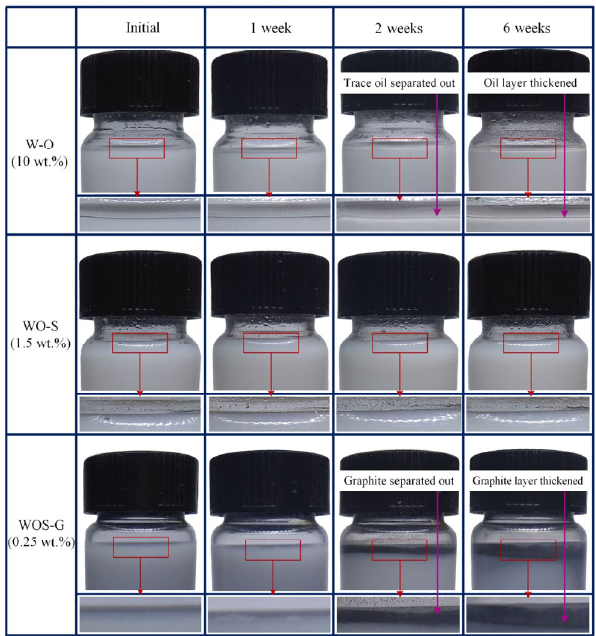
Fig. 6 Stability of the three preferred cutting fluids at room temperature (20  C).